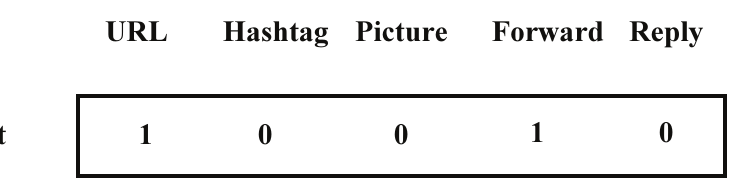
Figure 3. Sample of items in sending messages.